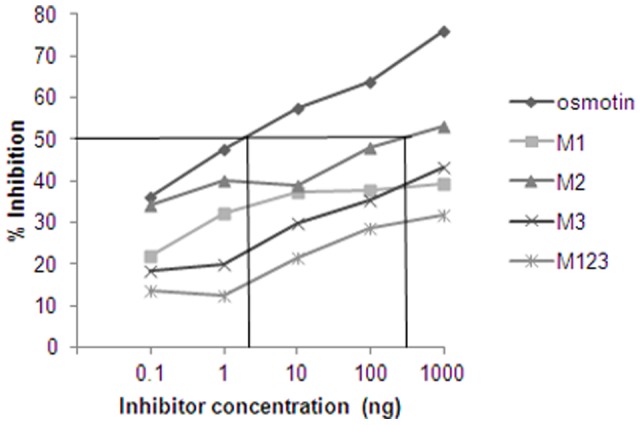
IgE reactivity of osmotin, M1, M2, M3 and M123.For IgE inhibition, osmotin positive patients' pooled sera were incubated with 0.1–1000 ng of osmotin protein and mutants as inhibitor. The assay was carried out with purified osmotin protein coated on microtitre plate. Competition of IgE binding to osmotin on the solid phase was quantified by ELISA. The (EC50) value for Osmotin is 4 ng and for M2 is 500 ng.